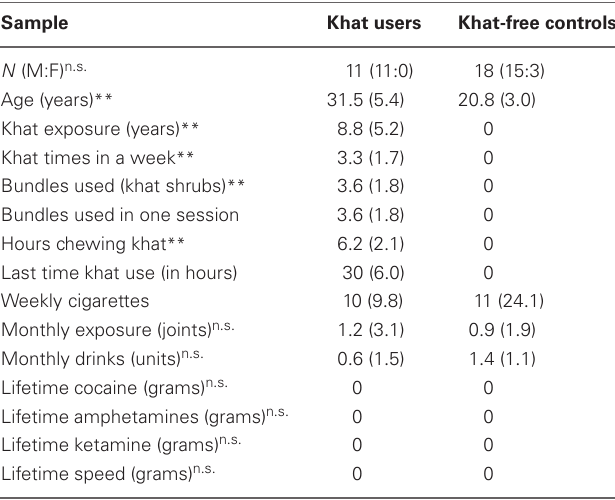
Table 1 | Demographic characteristics and self-reported use of khat and other psychoactive